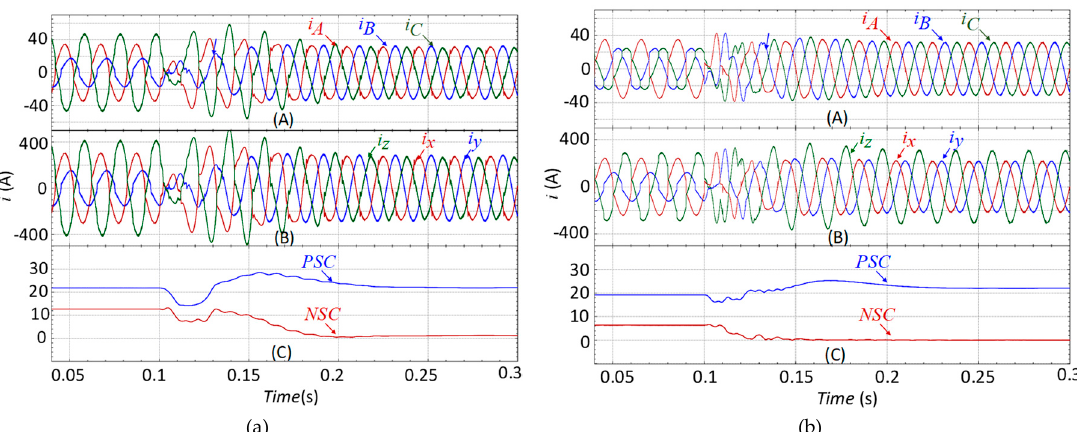
Figure 21. Three-phase power grid currents, PSC, and NSC of currents in V/V traction power system ( a ) and Scott traction power system ( b ) when the feeder section x has double the load of the feeder section y : ( A) three-phase currents after compensation at the primary windings of the power transformer; ( B) three-phase currents after compensation at the secondary windings of the power transformer; and (C) PSC and NSC of currents before and after compensation.